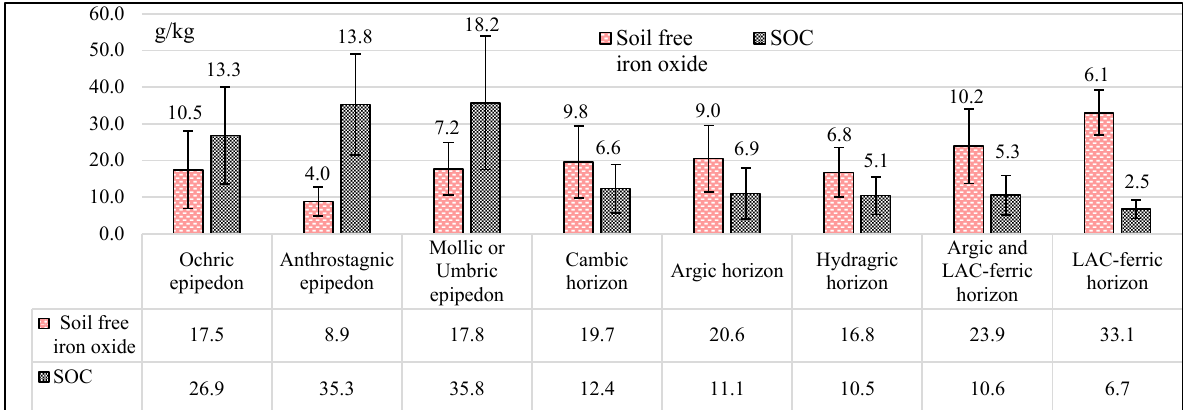
the external-heat potassium dichromate oxidation-colorimetric method [27], respectively.